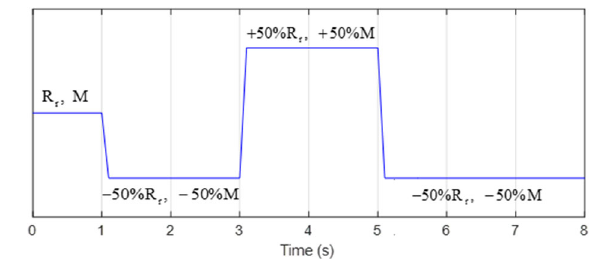
Fig. 20 Rotor resistance and mutual inductance variations